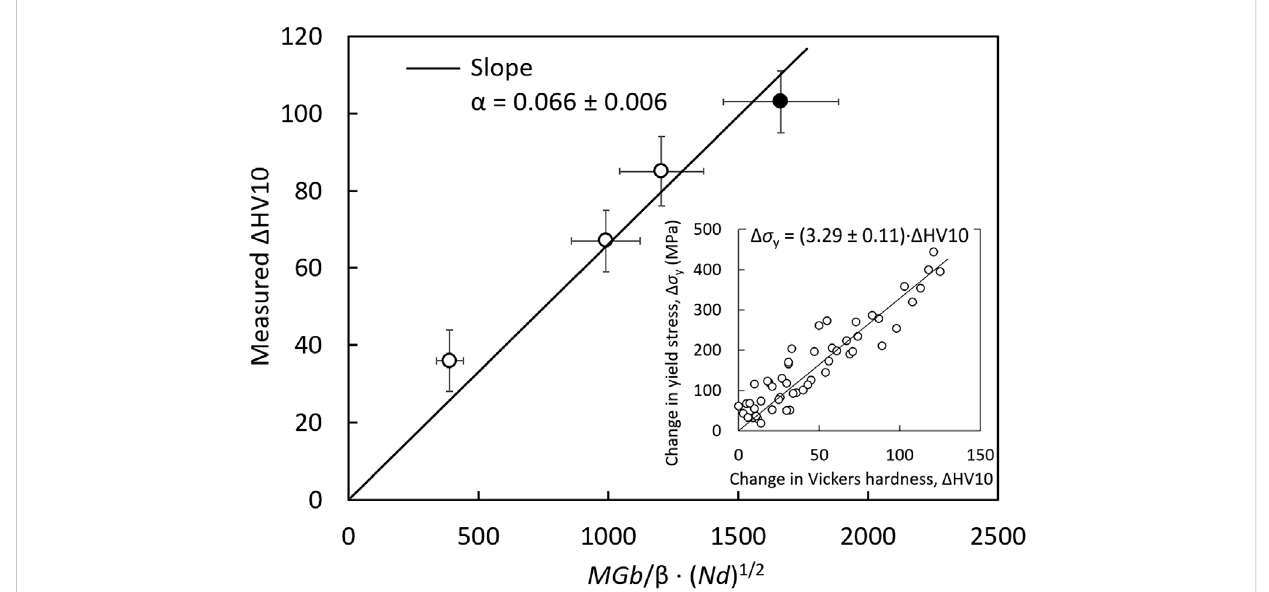
FIGURE 7 Increase of the Vickers hardness measured for the as-irradiated (full circle) and post-irradiation annealed (empty circles) conditions of VVER-1000 weld compared with the predictions based on Eq. 2. The inset indicates the conversion factor between changes of HV10 and yield stress.